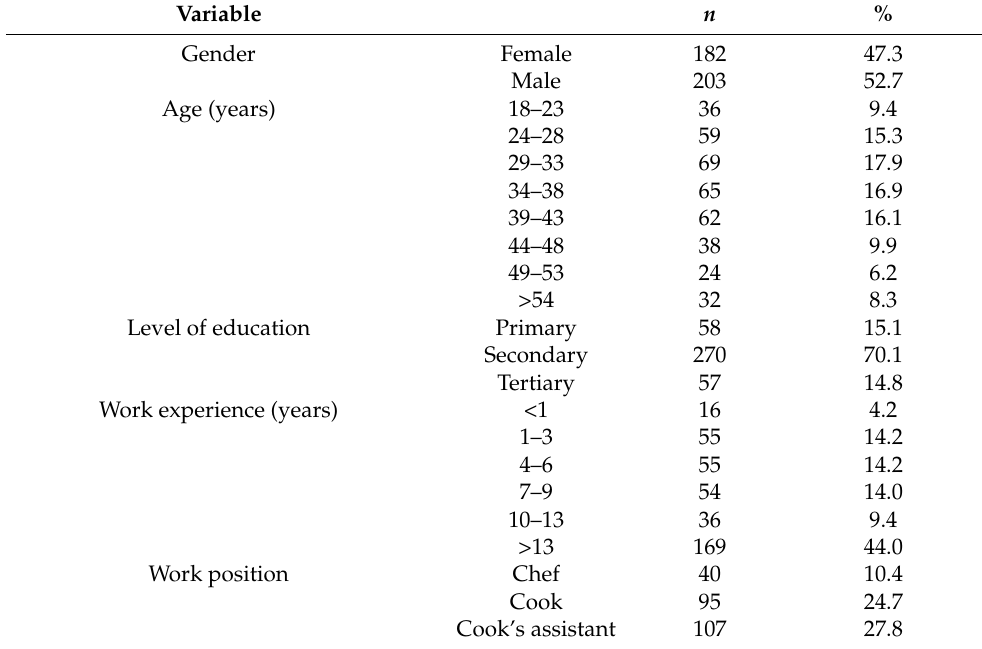
Table 1. Socio-demographic data of food handlers participating in the study ( n =